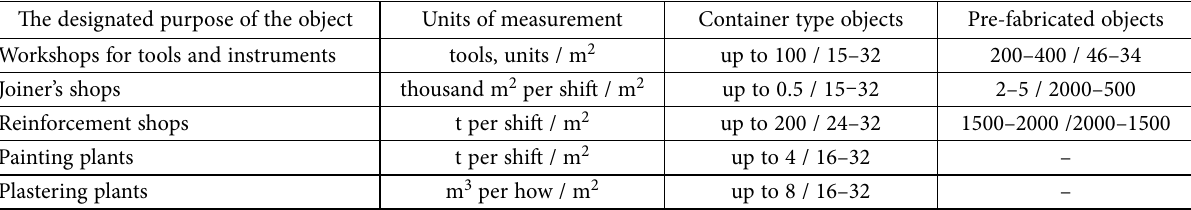
Table 2. Areas of industrial buildings